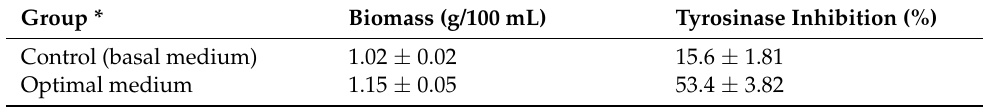
Table 1. Mycelia yield and tyrosinase inhibition rate after using the optimized culture conditions. Group * Control (basal